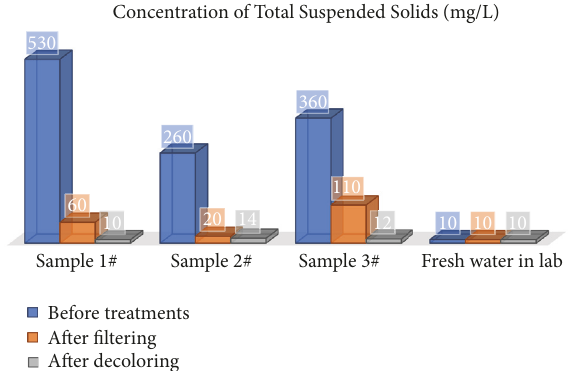
Figure 4: Concentrations of total suspended solids in different flowback samples (1#–3#) after filtering and decoloring treatments in the lab.